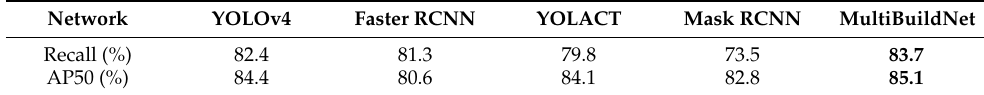
Table 5. Accuracy of building detection on the RSIBE